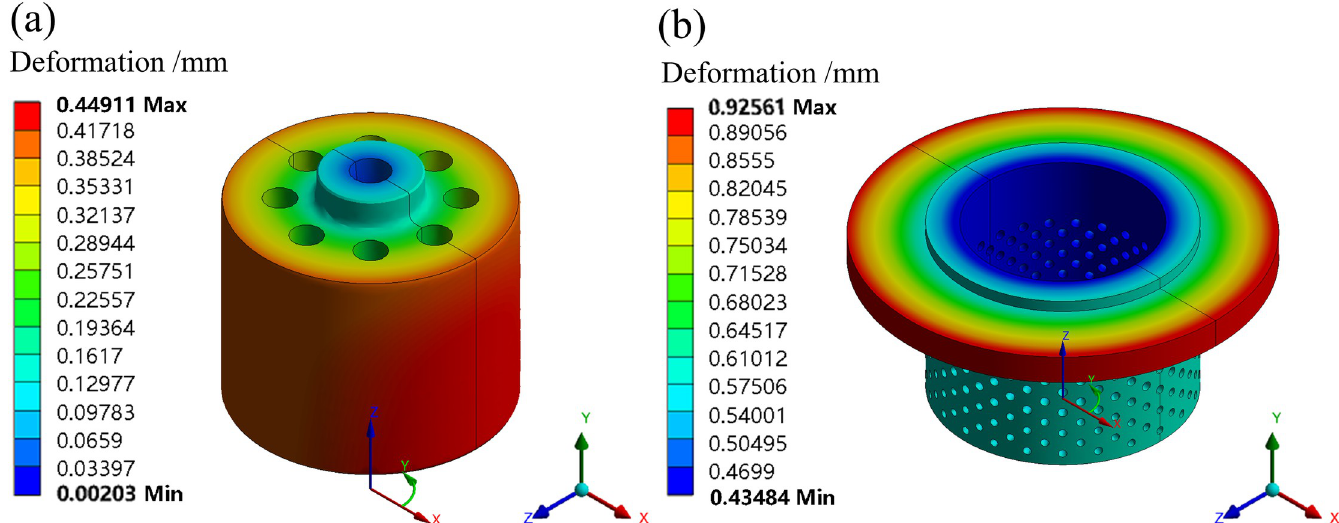
Fig 5. Radial deformation of the inner sleeve and valve plug at a 50% opening. (a) Valve plug. (b) Inner sleeve.